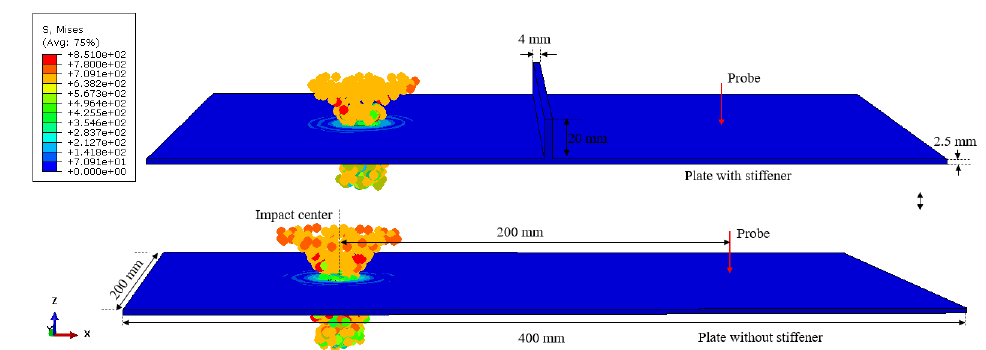
Figure 7. A screenshot of the numerical simulation model; velocity = 4 km/s; t = 1.6 × 10 − 5 s.